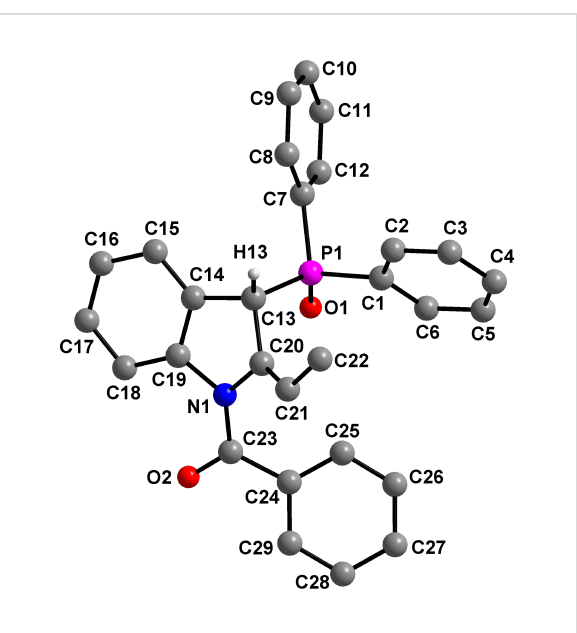
Figure 2: Molecular structure of compound 7 . Hydrogen atoms (except PCH) are omitted for clarity. Selected bond distances (Å): P1–C13 1.8402(15), C13–C20 1.5161(19), C13–C14 1.512(2), C20–N1 1.4508(18), C20–C21